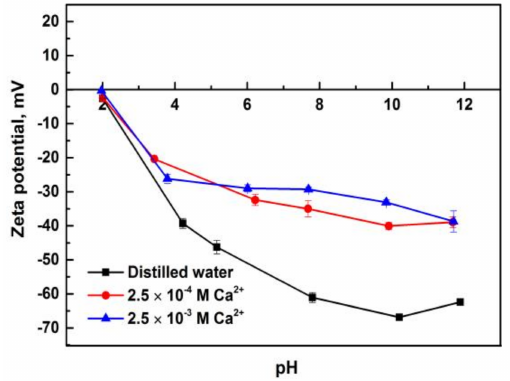
Figure 8. Zeta potential of quartz as a function of pH in the absence and presence of calcium